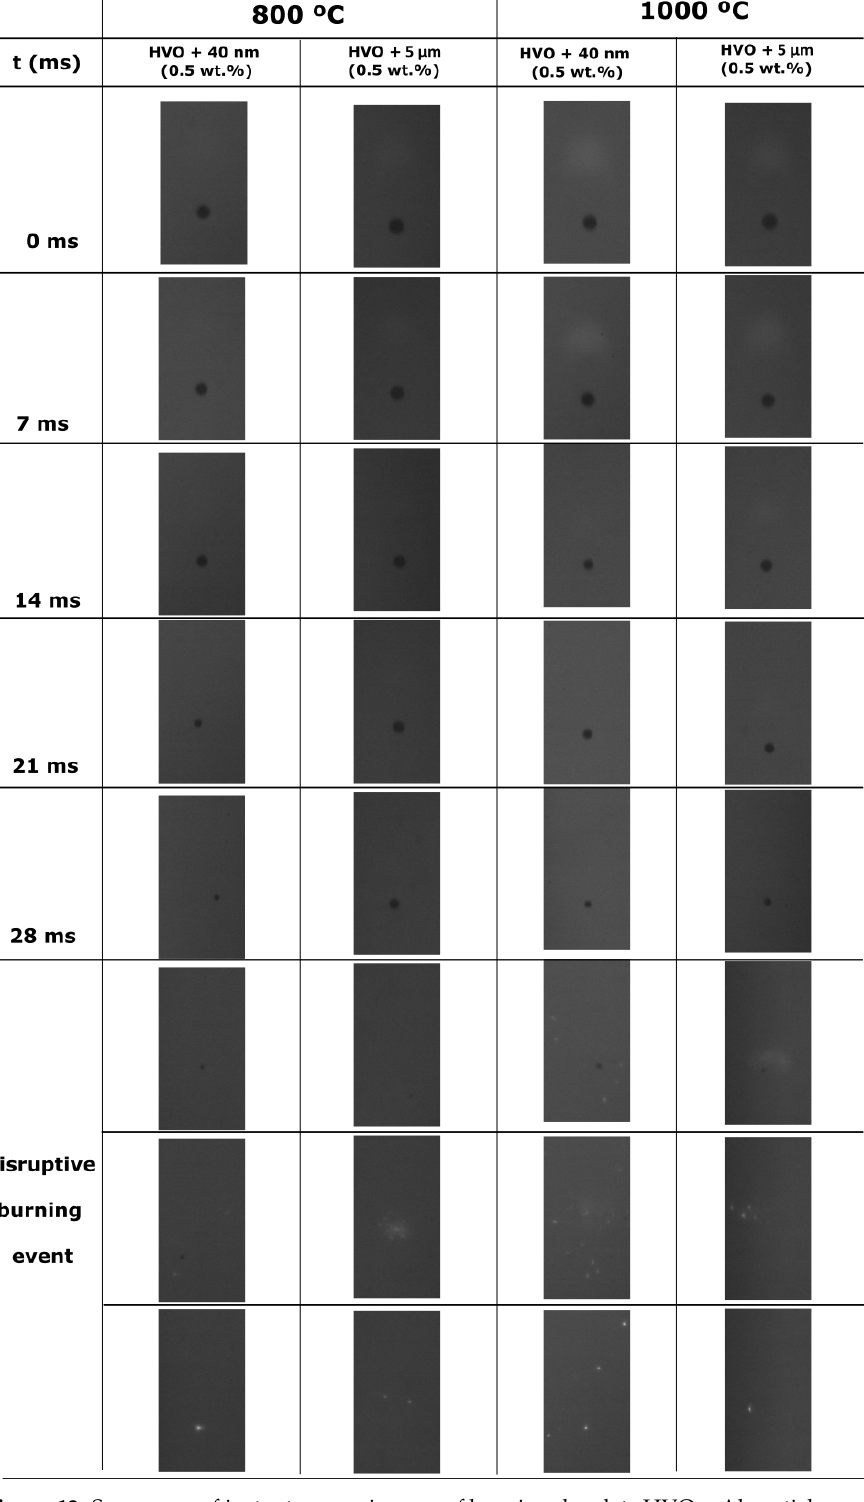
Figure 12. Sequences of instantaneous images of burning droplets HVO + Al